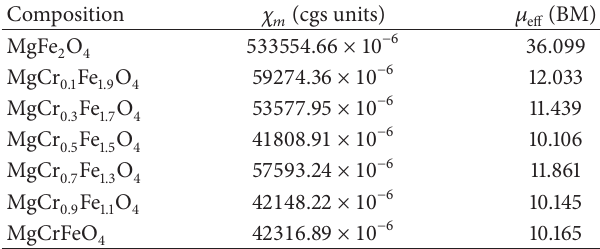
Table 2: Molar susceptibility ( 𝜒 𝑚 ) and effective magnetic